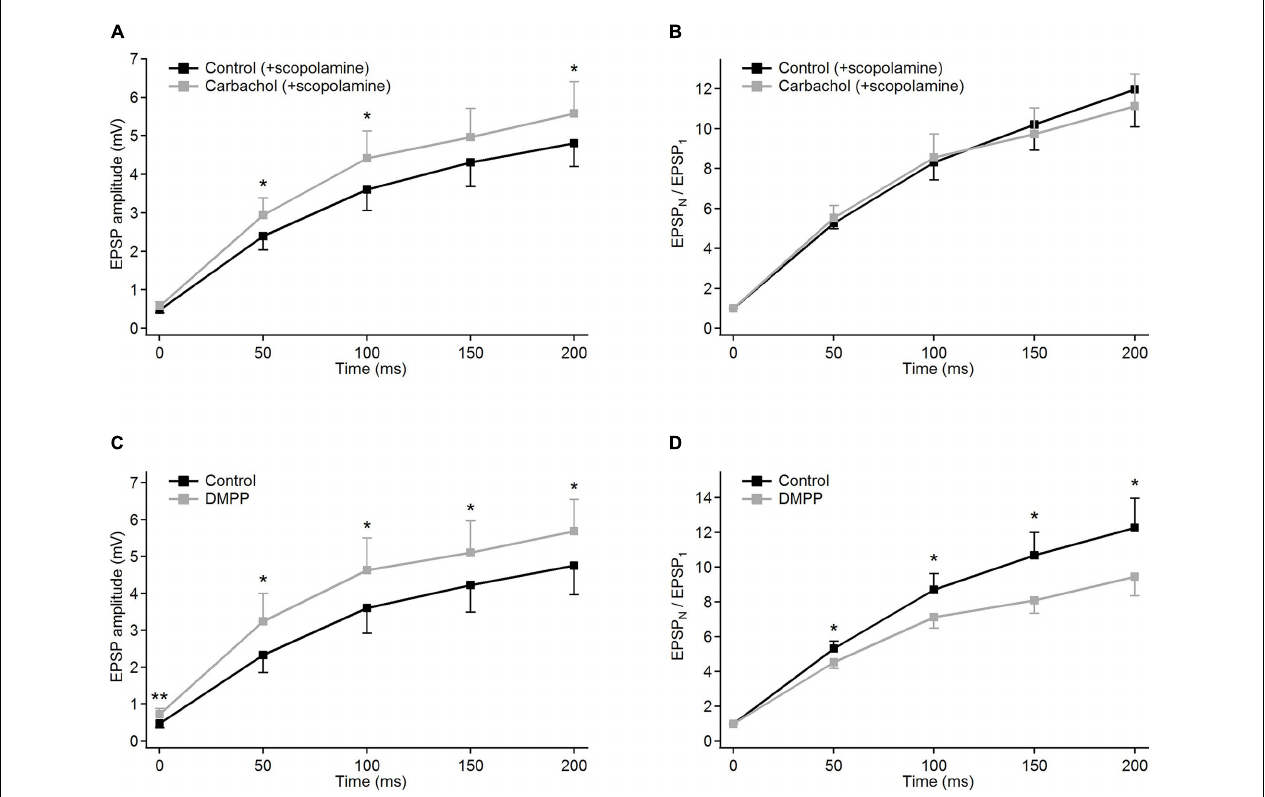
FIGURE 3 | Modulatory effects of different cholinergic agents on EPSP trains in PoM cells. (A,B) Blockade of muscarinic receptors by scopolamine: (A) EPSP amplitudes and (B) corresponding normalized EPSP amplitudes averaged for nine cells in the control condition (ACSF containing GABA inhibitors and 1 µ M scopolamine, black traces), and after adding 6–8 µ M carbachol (gray traces). (C,D) Blockade of nicotinic receptors by an agonist DMPP: (C) average EPSP amplitudes and (D) corresponding normalized EPSP amplitudes in control conditions with ACSF (black traces) and after application of 10 µ M DMPP (gray traces). Data are expressed as mean ± SEM, * P ≤ 0.05, ** P ≤